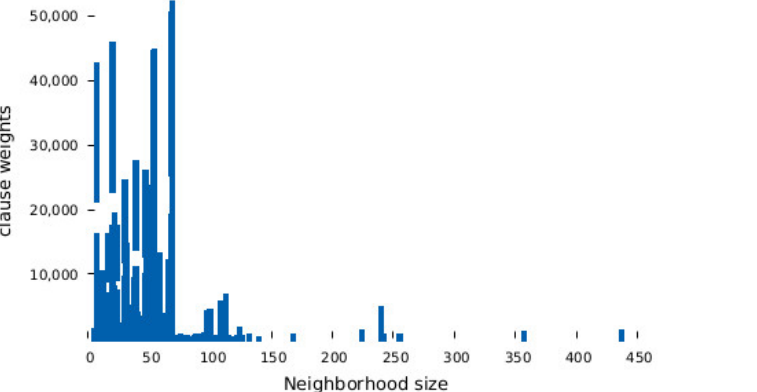
Figure 1. Weight distribution of the clauses of the bw_large problem until a solution is reached.